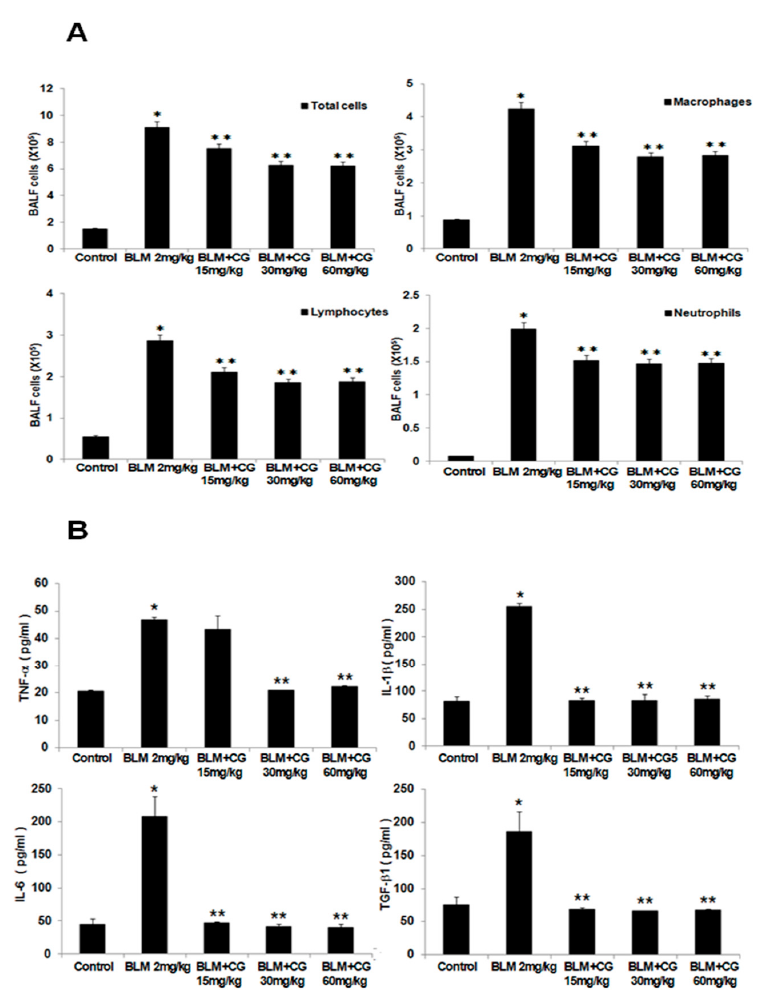
Figure 2. CG-745 ameliorates pulmonary inflammation induced by bleomycin in mice. ( A ) The number of total cells, macrophages, neutrophils, and lymphocytes in the bronchoalveolar lavage fluid (BALF) was counted. ( B ) The levels of TNF- α , IL-1 β , IL-6 and TGF- β 1 in the BALF were analyzed by ELISA. Data are presented as mean ± SD, n = 5. * p < 0.01 versus control group. ** p < 0.05 versus bleomycin group.